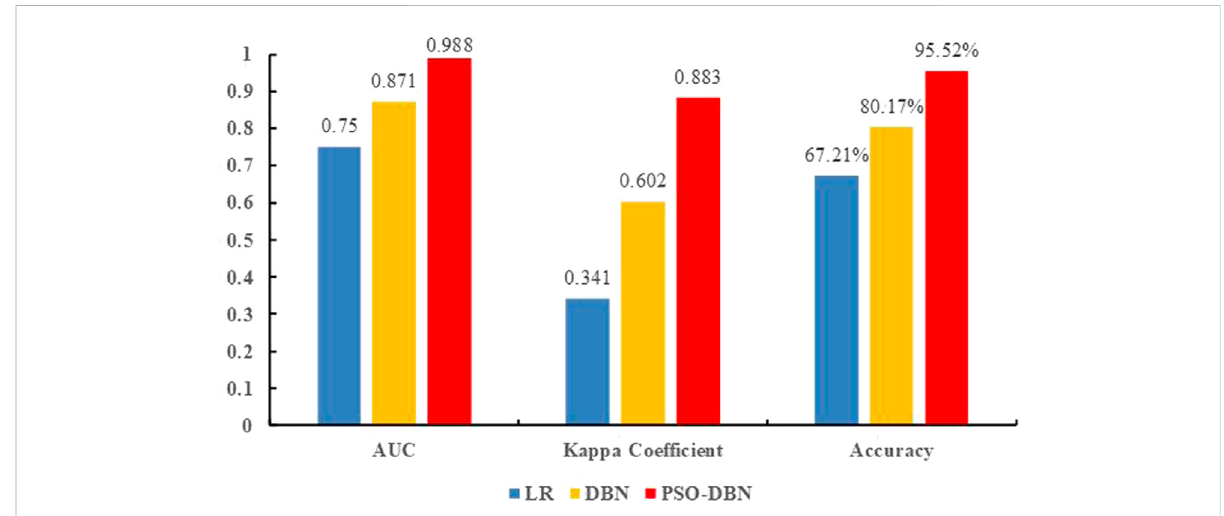
FIGURE 6 Comparison of performance indexes between logistic regression model, general DBN model and PSO-DBN model